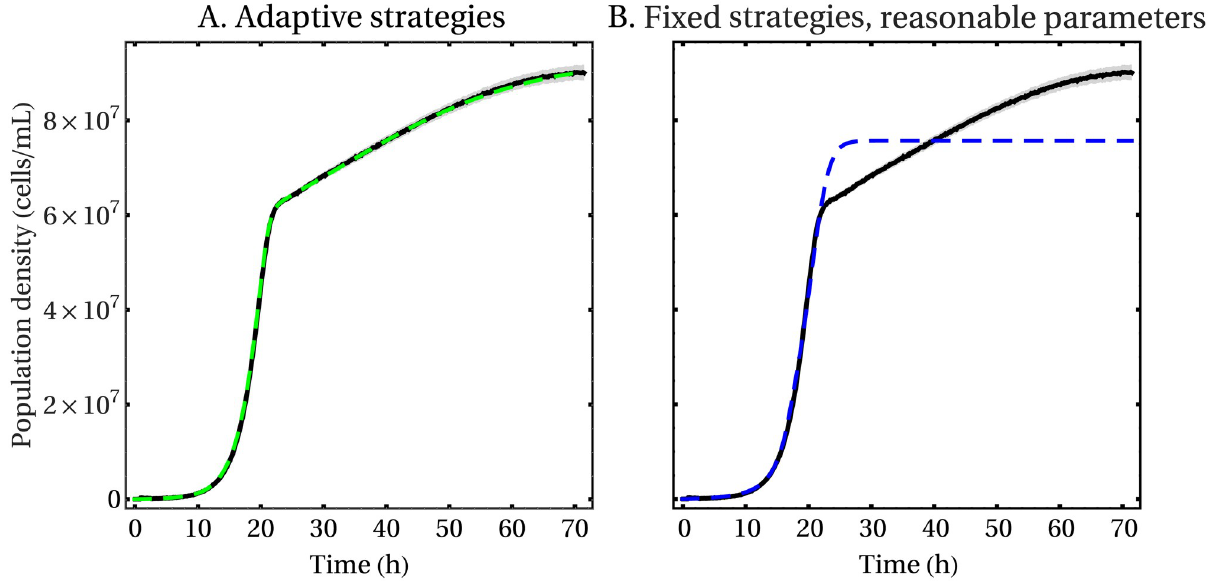
Fig 1. Comparison between the best fits of MacArthur’s consumer-resource model (dashed lines) and experimental measures of the growth of S. cerevisiae on galactose as the primary carbon source and ethanol as a byproduct of fermentation, in the case of adaptive (A) and fixed (B) metabolic strategies. Shown are the mean (black lines) and the standard error (gray bands) across n = 8 replicate populations. In (A) the model is not only capable to reproduce very well the experimental data, but the best fit returns parameters whose values are biologically reasonable when contrasted with experimentally-measured ones found in the literature (see Table A in S1 Text). On the other hand, the fit in (B) cannot reproduce a diauxic behavior when the parameters are constrained to vary within a few orders of magnitude away from biologically reasonable values (see Table A in S1 Text). See S1 Text for details on how the fits were performed and the resulting values of the best fit parameters.